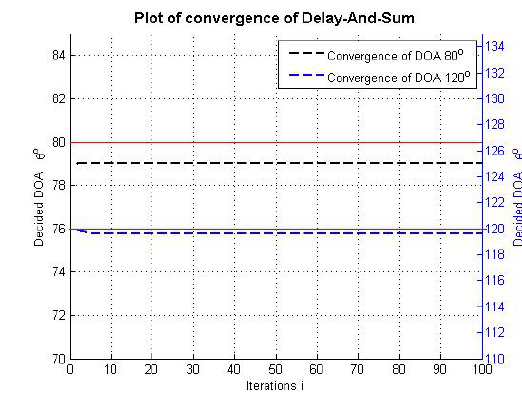
for case 2(b) ( 𝐼 ) 𝜃